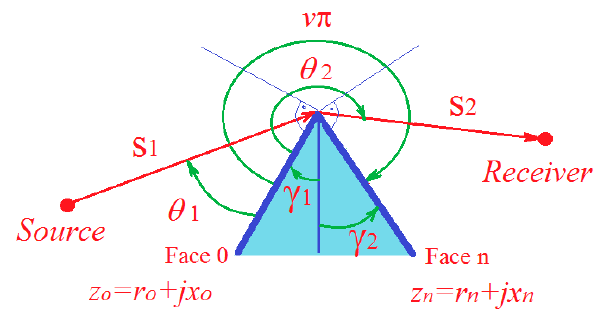
Figure 9. Notation used in a single diffracting wedge. Reflection coefficients for the 0 face, with incidence angle θ 1 , and for the n face, with reflection angle v π − θ 2 .